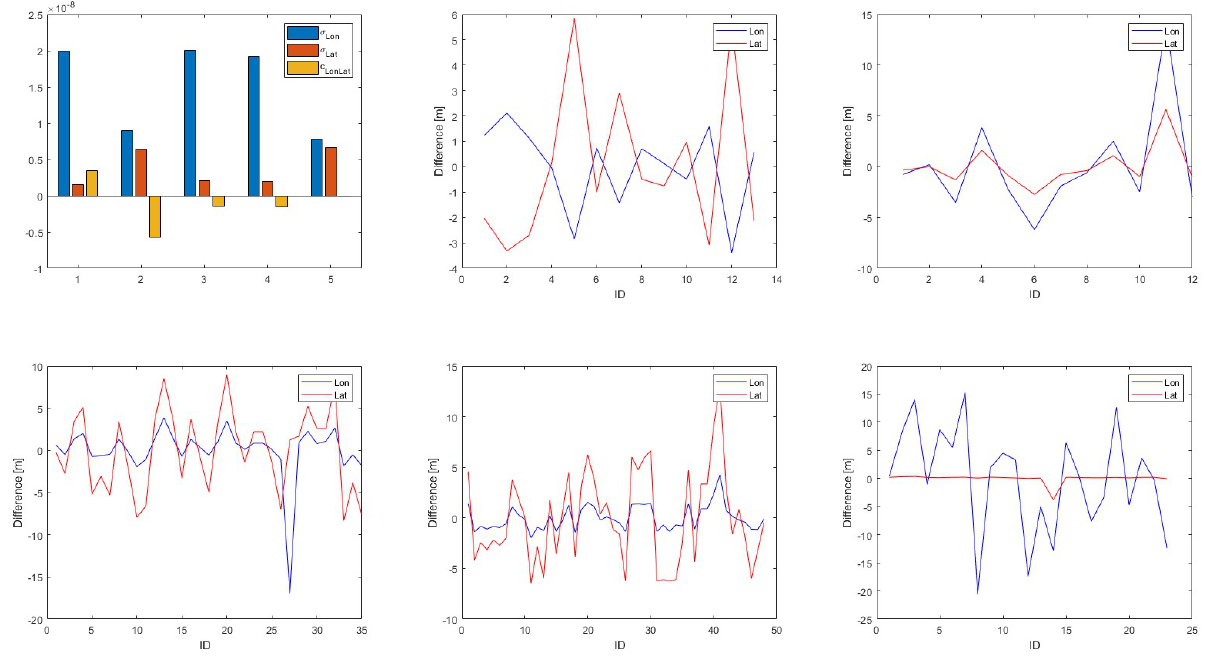
Figure 3. The obtained differences at the test points (OpenStreetMap case